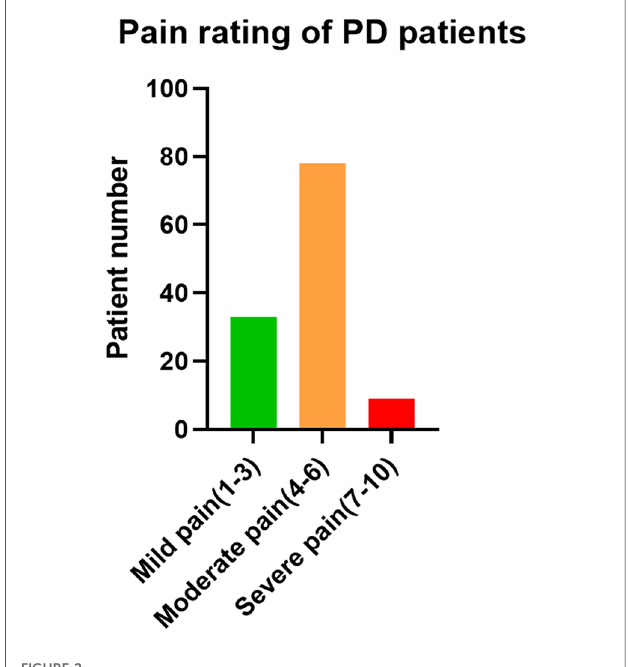
FIGURE 2 The PD patient number of each pain rating.